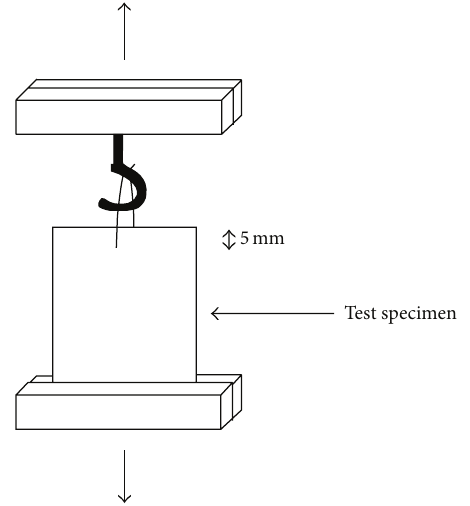
Figure 1: Measuring method for suture holding strength adopted from Reference